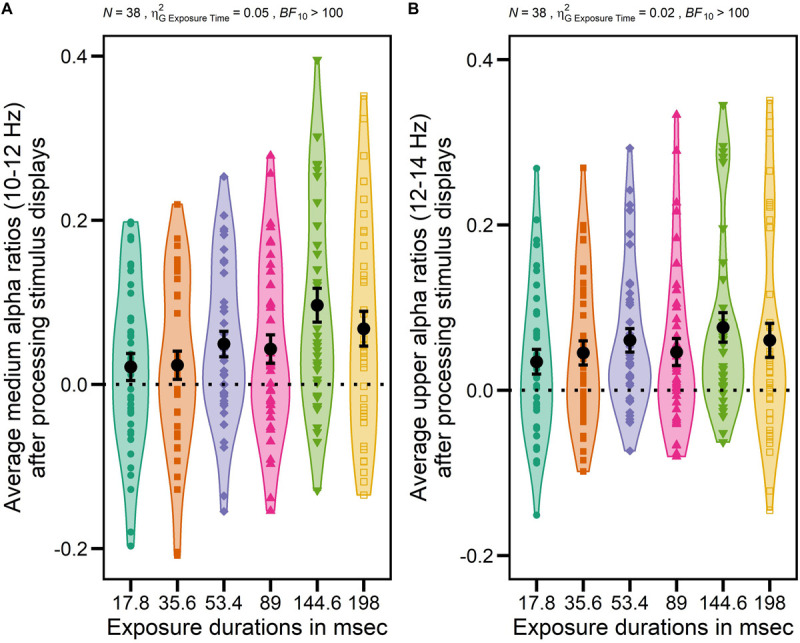
Impact of different exposure durations on average medium alpha ratios (10–12 Hz) and average upper alpha ratios (12–14 Hz) after processing stimulus displays. Averages were computed based on log-transformed medium and upper alpha ratios using log10. Average alpha ratios > 0 indicate event-related desynchronization (ERD); average alpha ratios < 0 event-related synchronization (ERS). N indicates the number of participants, ηG2 generalized eta-squared, BF10 the evidence in support of the H1, and the dotted horizontal line indicates the absence of any modulation of alpha activity (alpha ratio = 0). Participants’ individual average medium or upper alpha ratios for each exposure duration are indicated by different colors (17.8 ms: green, 35.6 ms: orange, 53.4 ms: purple, 89 ms: pink, 144.6 ms: light green, 198 ms: yellow) and shapes (17.8 ms: circle, 35.6 ms: square, 53.4 ms: diamond, 89 ms: triangle, 144.6 ms: triangle upside down, 198 ms: empty square). Total averages over all participants of each exposure duration are indicated by black dots. Error bars indicate standard errors. The main effect EXPOSURE DURATION was significant for medium alpha ratios after processing stimulus displays indicating that the extent of alpha power attenuation in a frequency band from 10 to 12 Hz after stimulus processing increased in relation to increasing exposure durations up to 144.6 ms (i.e., ERD) but started to decrease with even longer exposure duration again (i.e., ERS) (A). A similar effect was found for upper alpha ratios (B).